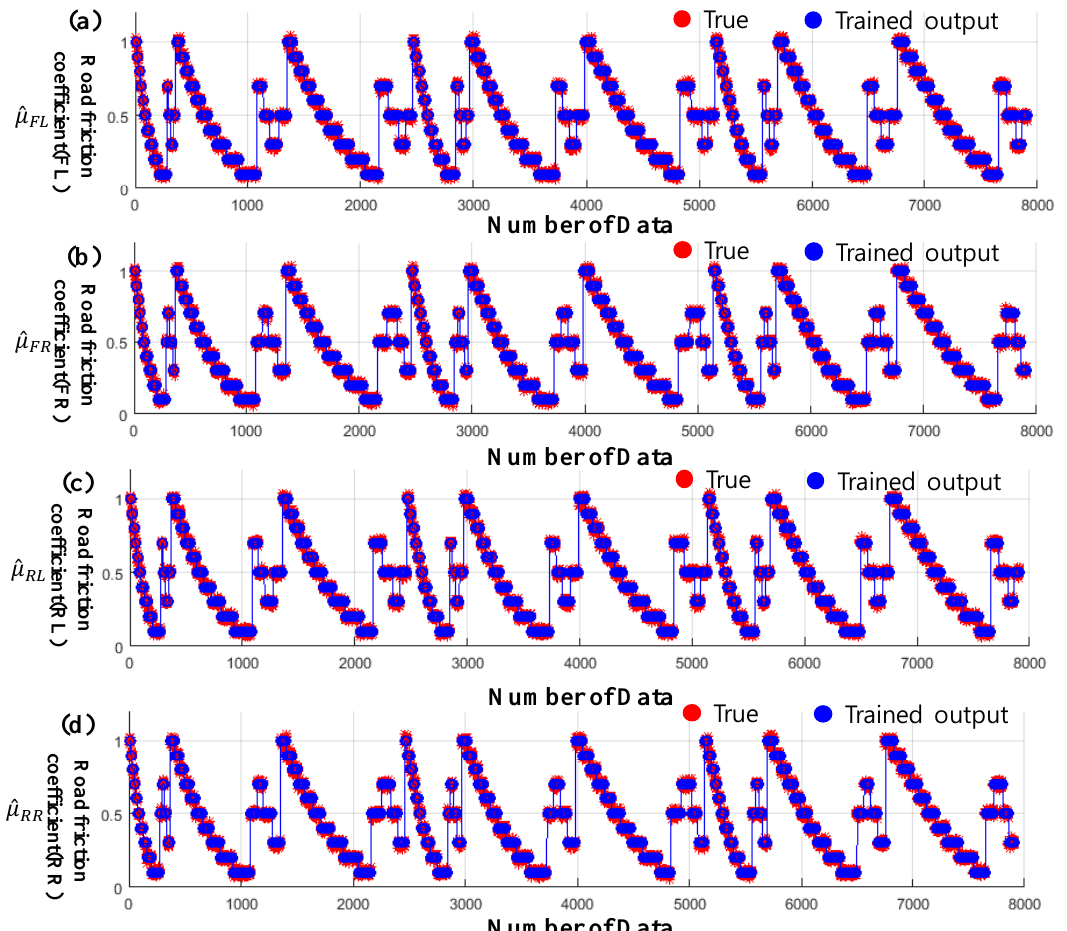
Figure 11. Comparison between true references and trained outputs. ( a ) Front left wheel (FL), ( b ) front right wheel (FR), ( c ) rear left wheel (RL), and ( d ) rear right wheel (RR).